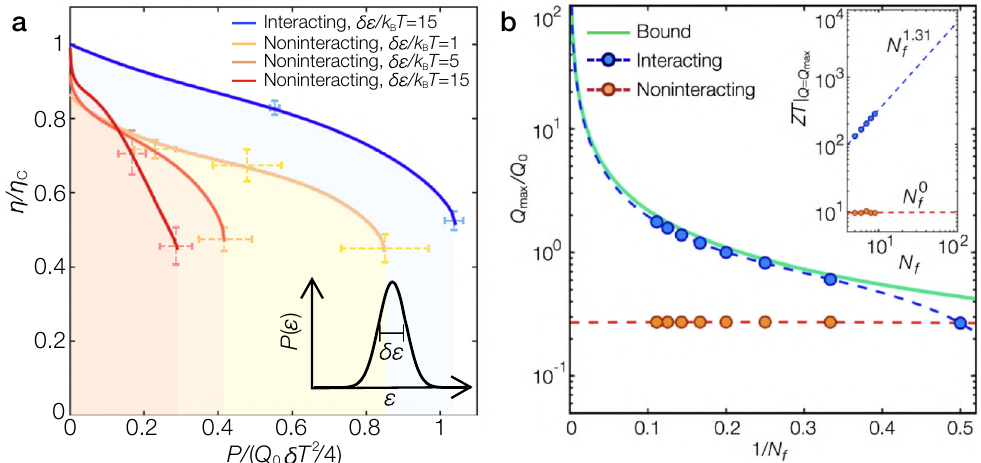
Fig. 3 Comparisons between noninteracting and interacting optimal heat engines. a Power-ef fi ciency bound under randomly generated single-electron energies. The inset illustrates the fact that single-electron energies are randomly sampled from the Gaussian probability distribution with the width δϵ . The main panel shows the ef fi ciency-power bounds obtained at different widths δϵ , and with or without interactions. The noninteracting bounds substantially degrade as the width δϵ is increased. The interacting bound is almost insensitive to a speci fi c choice of δϵ , and we plot the result for δϵ / k B T = 15 as a blue solid curve. The dashed error bars indicate the standard deviations of the numerical results. We set N f = 5, γ h = γ c ≡ γ , and plot the power in terms of Q 0 δ T 2 /4 with Q 0 = k B γ / T . Here, N f is the number of single-electron levels, γ h,c are hopping rates to the hot and cold reservoirs, respectively. b Finite-size scaling of the maximum possible power. The blue dashed curve shows an extrapolation of the highest-power factors at different sizes N f P 4 = Q a N i (cid:2) 3 fi tting parameters a using the form Q ¼ i i ¼ 1 f , with 1,2,3,4 . It asymptotically achieves the fundamental bound (cf. Eq. (5)) indicated by the max 0 green solid curve. The inset plots the associated fi gure of merit ZT j Q ¼ Q of the highest-power machine against N f , where the blue dashed line shows max the fi tted scaling ZT j Q ¼ Q / N 1 : 31 f . The noninteracting results obtained under the same setting of generic (nondegenerate) single-electron levels fi tted max from N f -independent extrapolations are shown by the red dashed lines. The dots represent the data points at each value of N f . We set ϵ l = l Δ with Δ / k B T = 3 and γ h = γ c ≡ γ